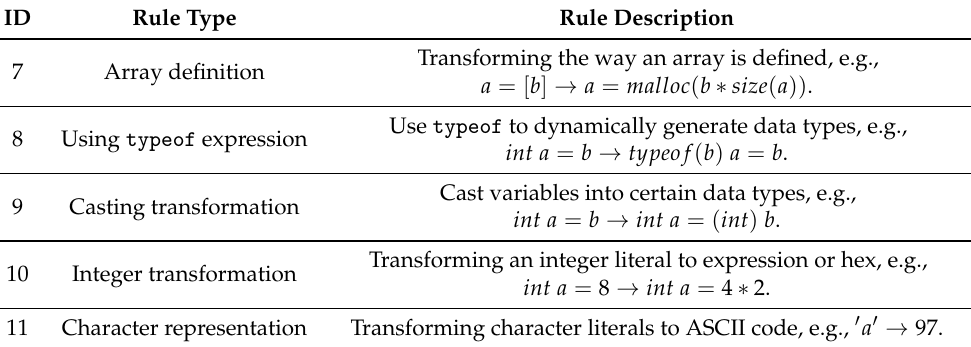
Table 2. Data transformation